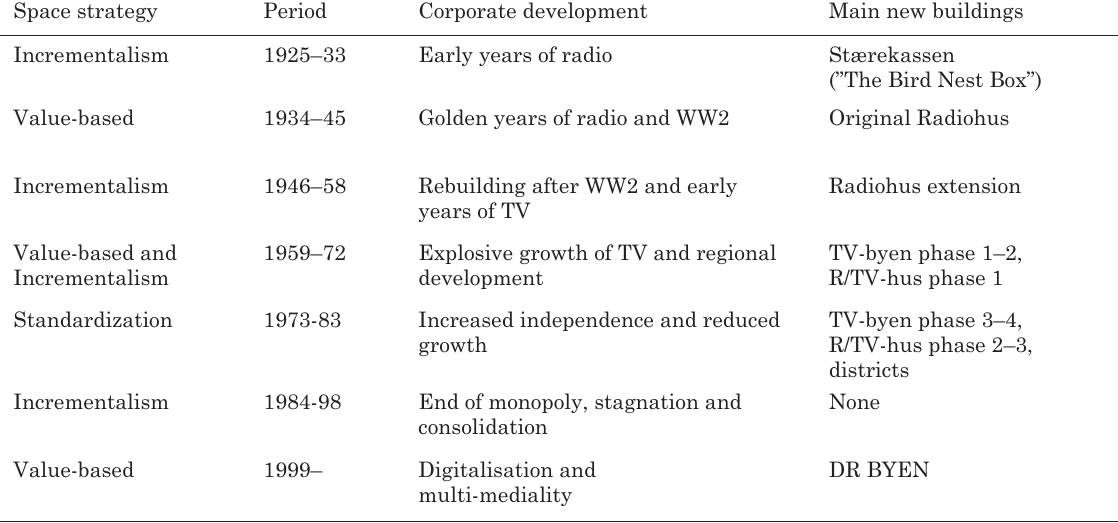
table 2. Summary of Dr’s space strategies in 7 periods Space